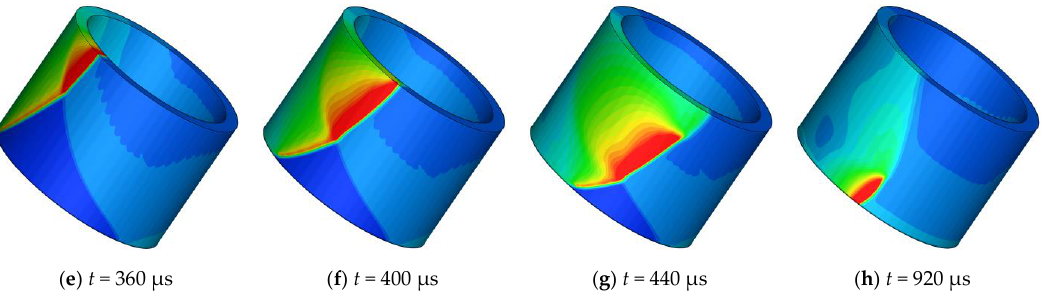
Figure 7. Pressure contour in the RDC with θ = 0°.